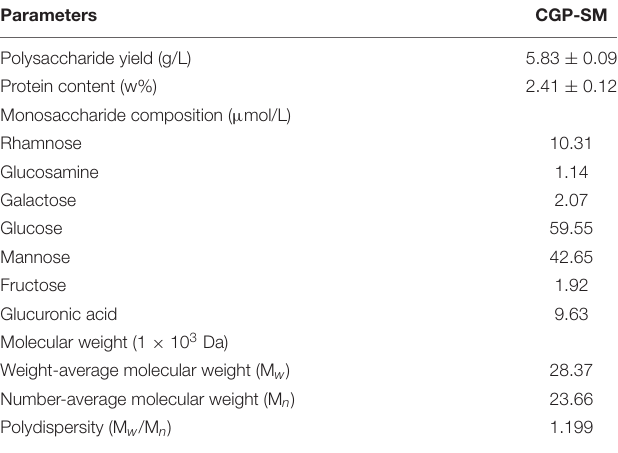
into a 25 ml volumetric flask, diluted to 25 ml by adding